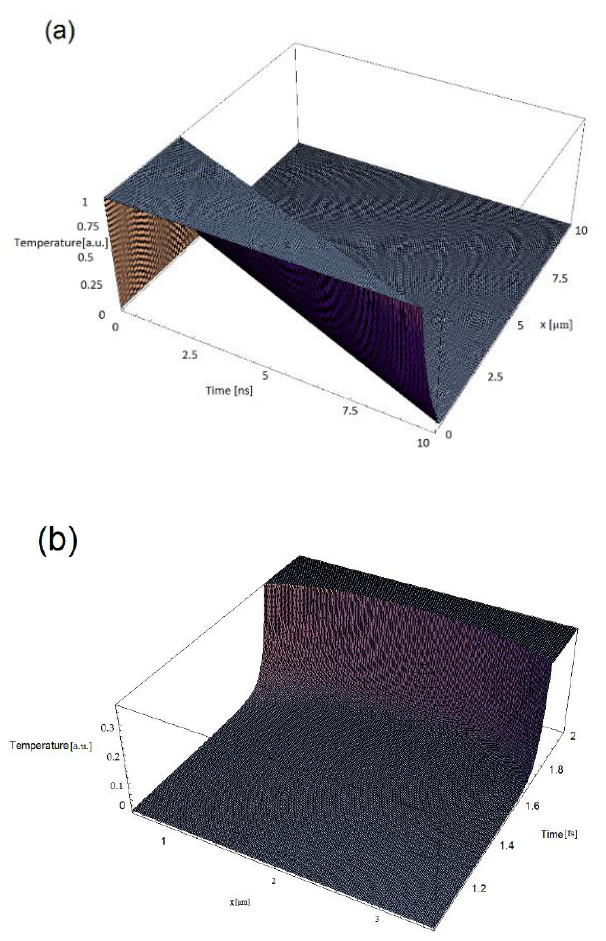
Figure 1. Spatial-temporal electron temperature distribution generated by a 100 fs laser pulse in an Au target for 𝜏 = 1 𝑝𝑠 relaxation time and (a) 10 ns or (b) 2 fs simulation time, respectively.